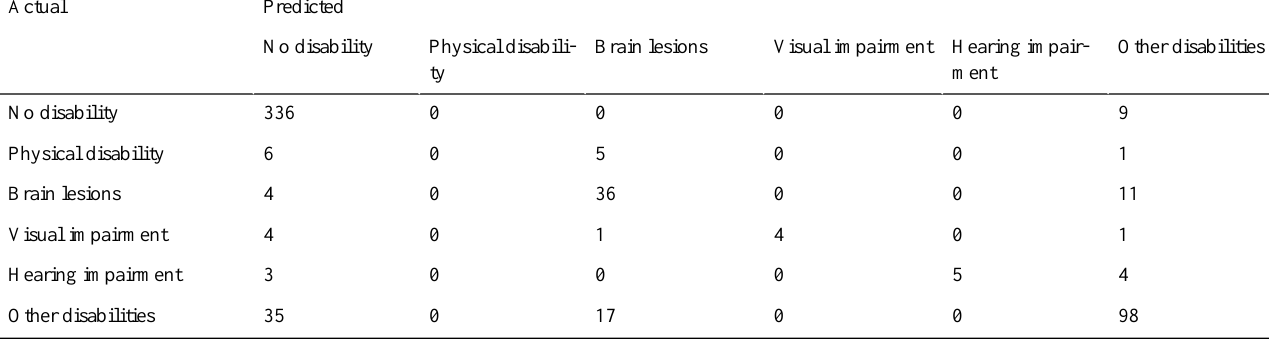
Table 8. Confusion matrix when using disease diagnostic and prescription